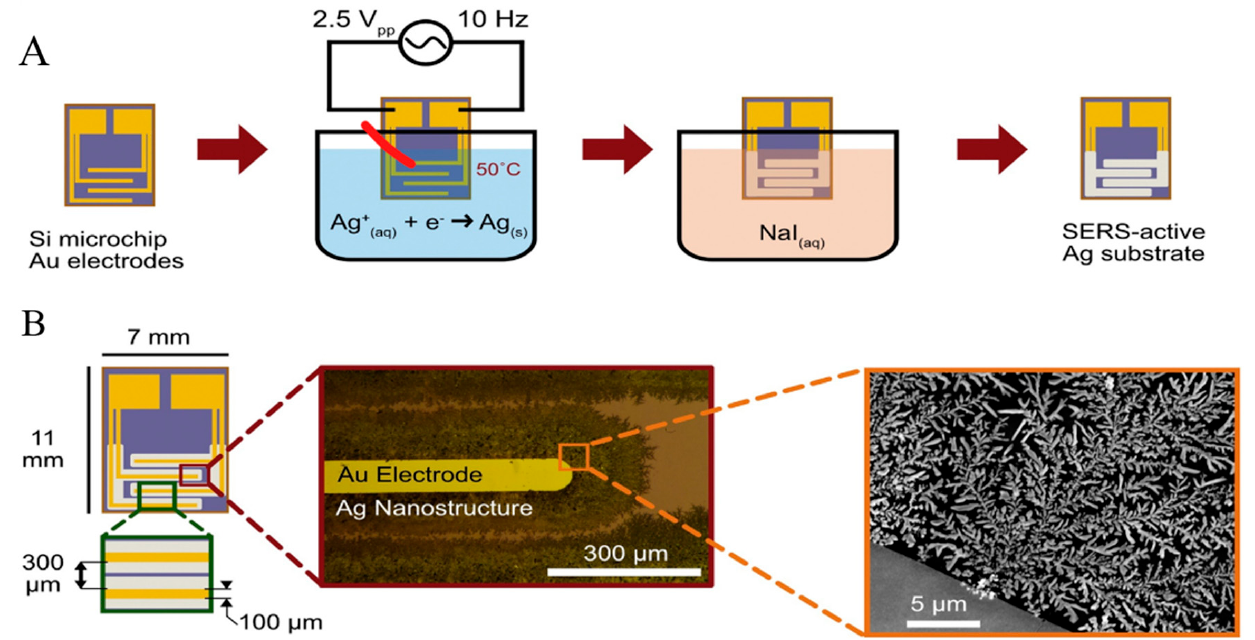
Figure 3. ( A ) SERS substrate assembly through reduction in Ag ions on the edges of interdigitated Au electrodes. ( B ) electrodes act as a template for the electrochemical growth of Ag nanostructures [88].